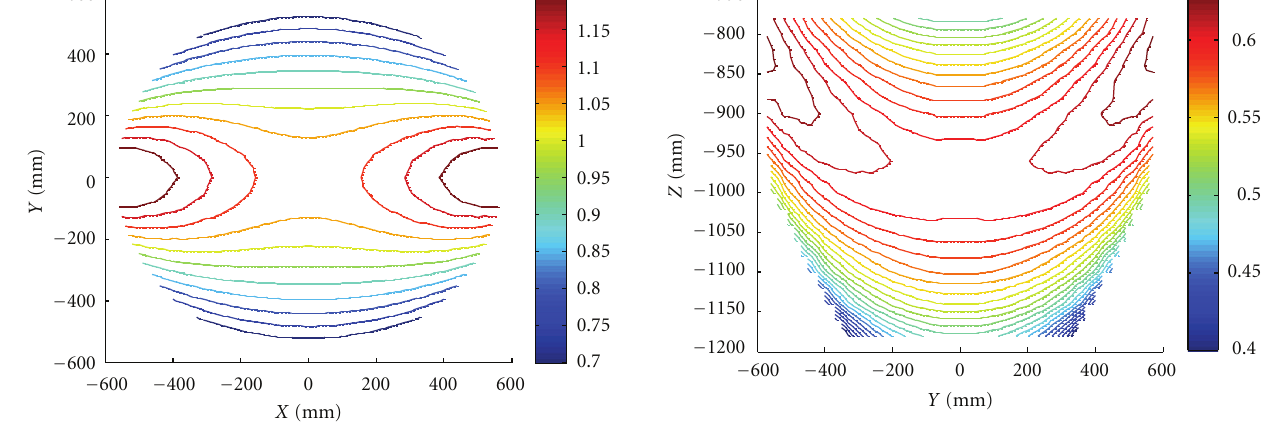
Figure 10: DSI μ Y in the XY plane ( Z = − 900).